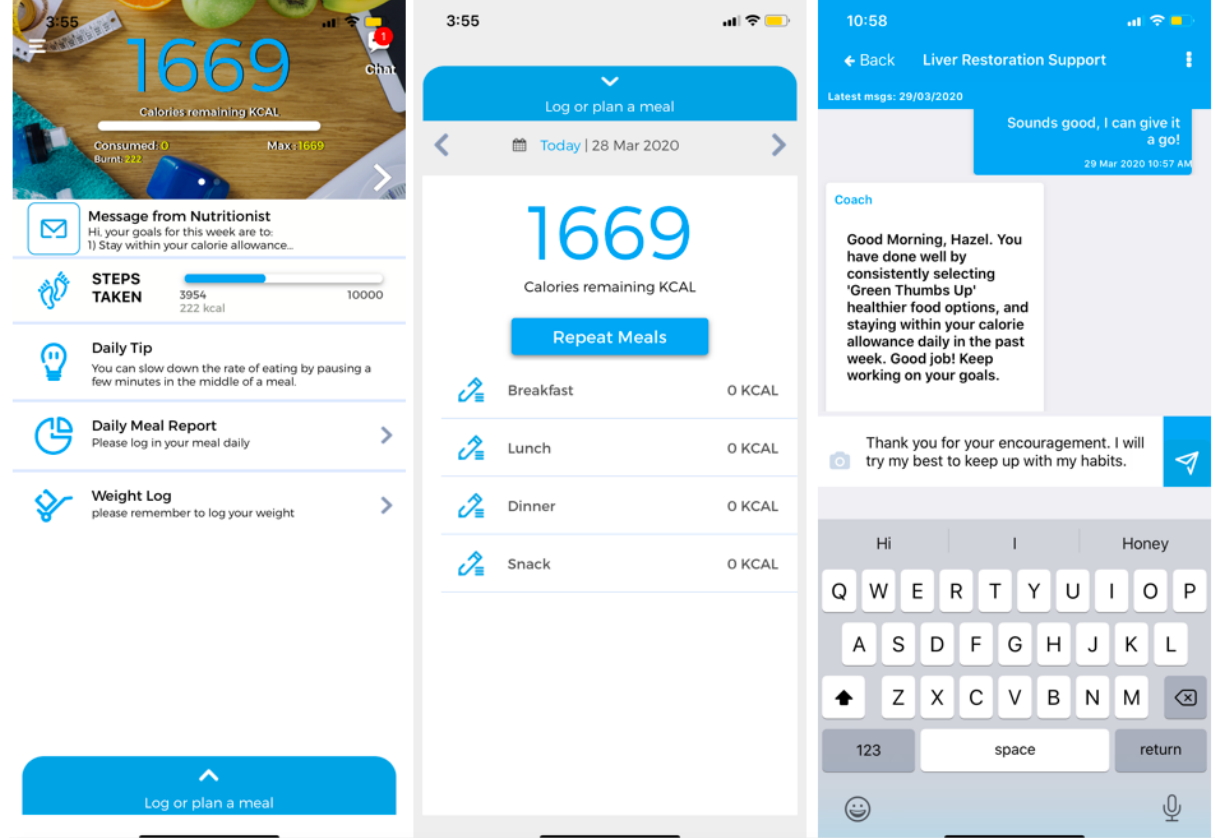
Figure 1. Screenshot of nBuddy homepage, food log page, and dietitian support chat channel from left to right,